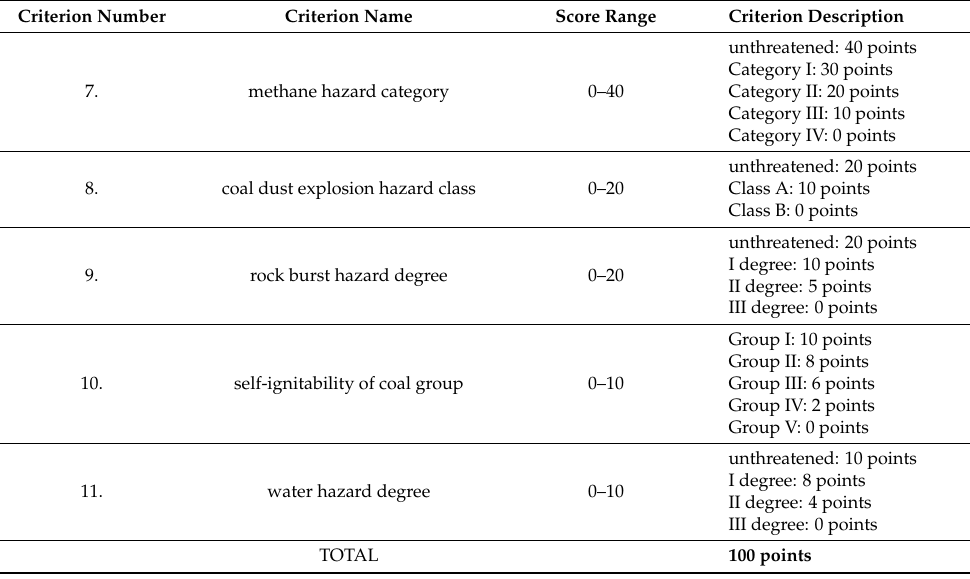
Table 2. The principles for assessing criteria referring to natural